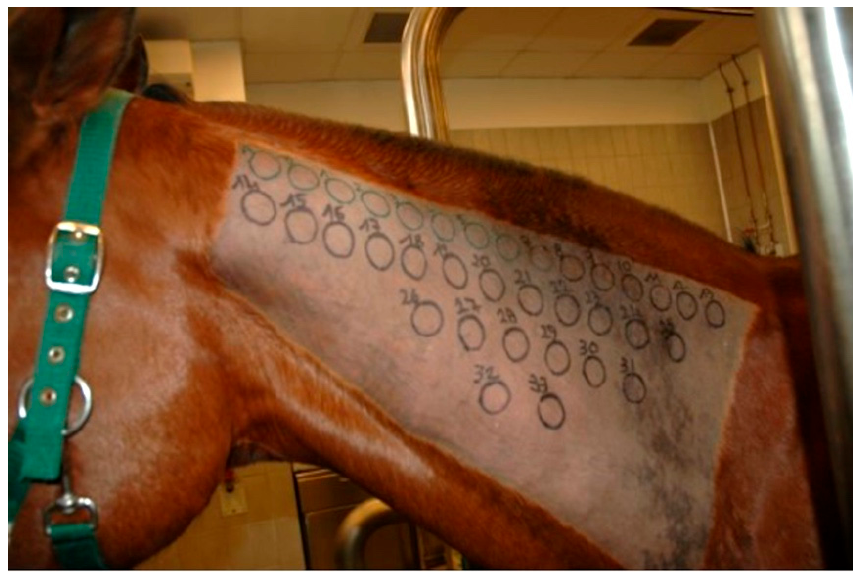
Figure 1. The lateral aspect of the neck has been clipped and circles were drawn with a black marker to indicate injection sites.